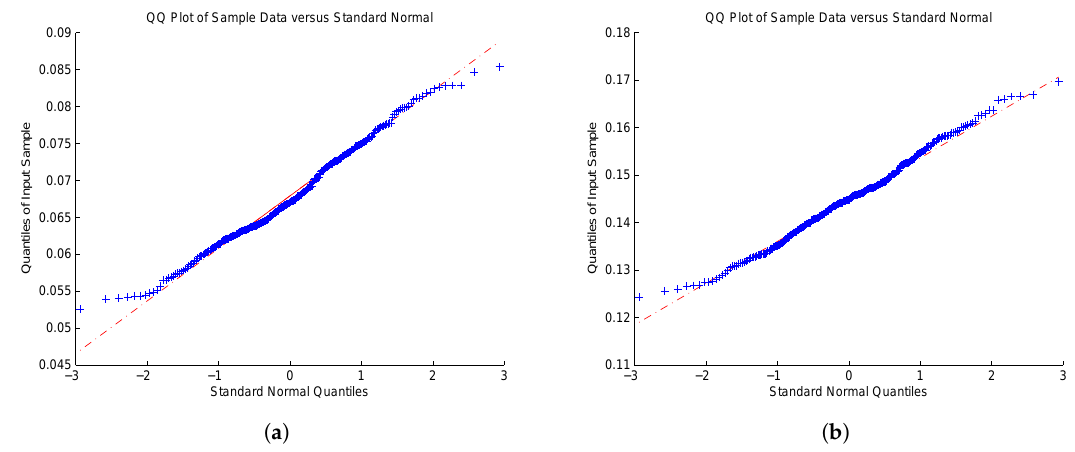
Figure 5. QQ-plot of (cid:98) φ K ( 3 ) for (GS); ( a ) T n = 120, and ( b ) T n =